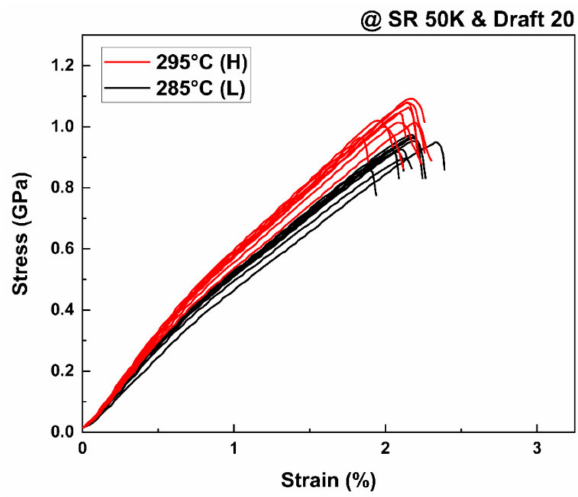
Figure 4. Variation of stress-stain curves of the as-spun TLCP fibers, prepared at the shear rate of 50,000 s − 1 and the draft of 20, by the change in spinning temperatures (285 and 295 ◦